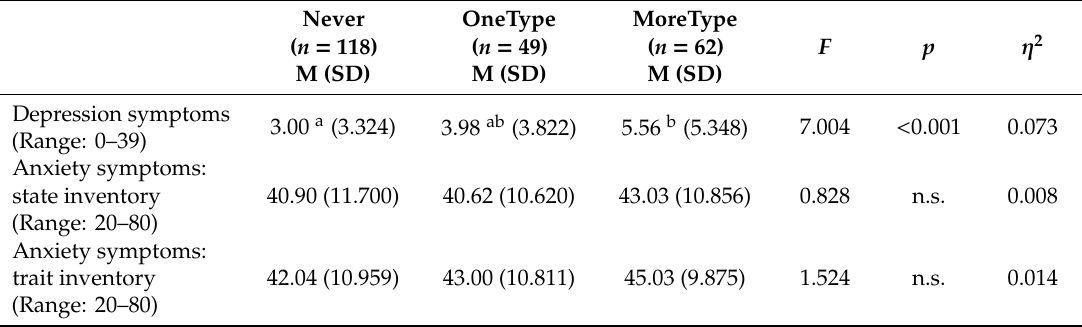
Table 2. Depression and anxiety symptoms: comparison between Never, OneType, and MoreType (one-way ANOVA) victims. Notes: M, mean; SD, standard deviation; F, Fisher’s ratio; n.s., not statistically significant. Significantly di ff erent means are indicated with di ff erent superscript letters.